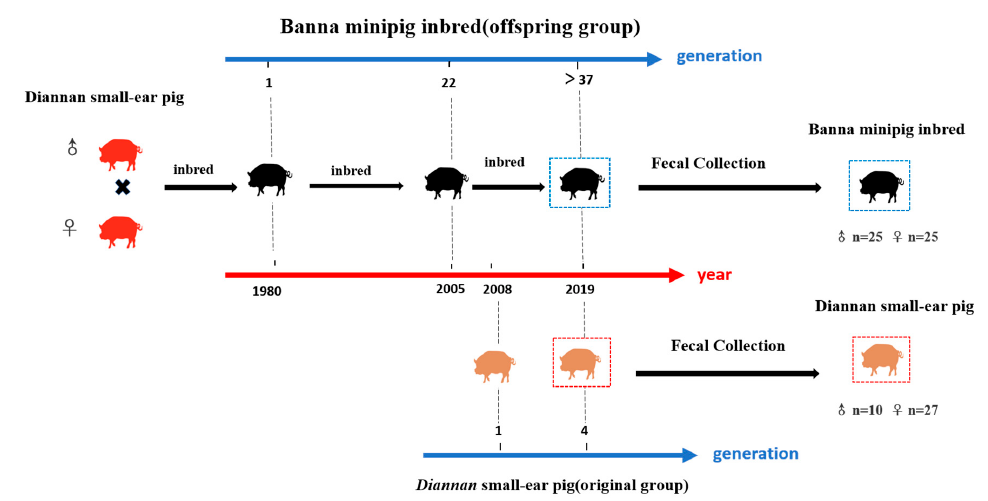
Figure 1. Sample collection of Diannan small-ear pig and Banna minipig inbred. Banna minipig inbred was the inbreeding from full and half-siblings of Diannan small-ear pig in 1980 and now it has been inbred for over 37 generations. The Diannan small-ear pig in this experiment has been conserved for 4 generations since